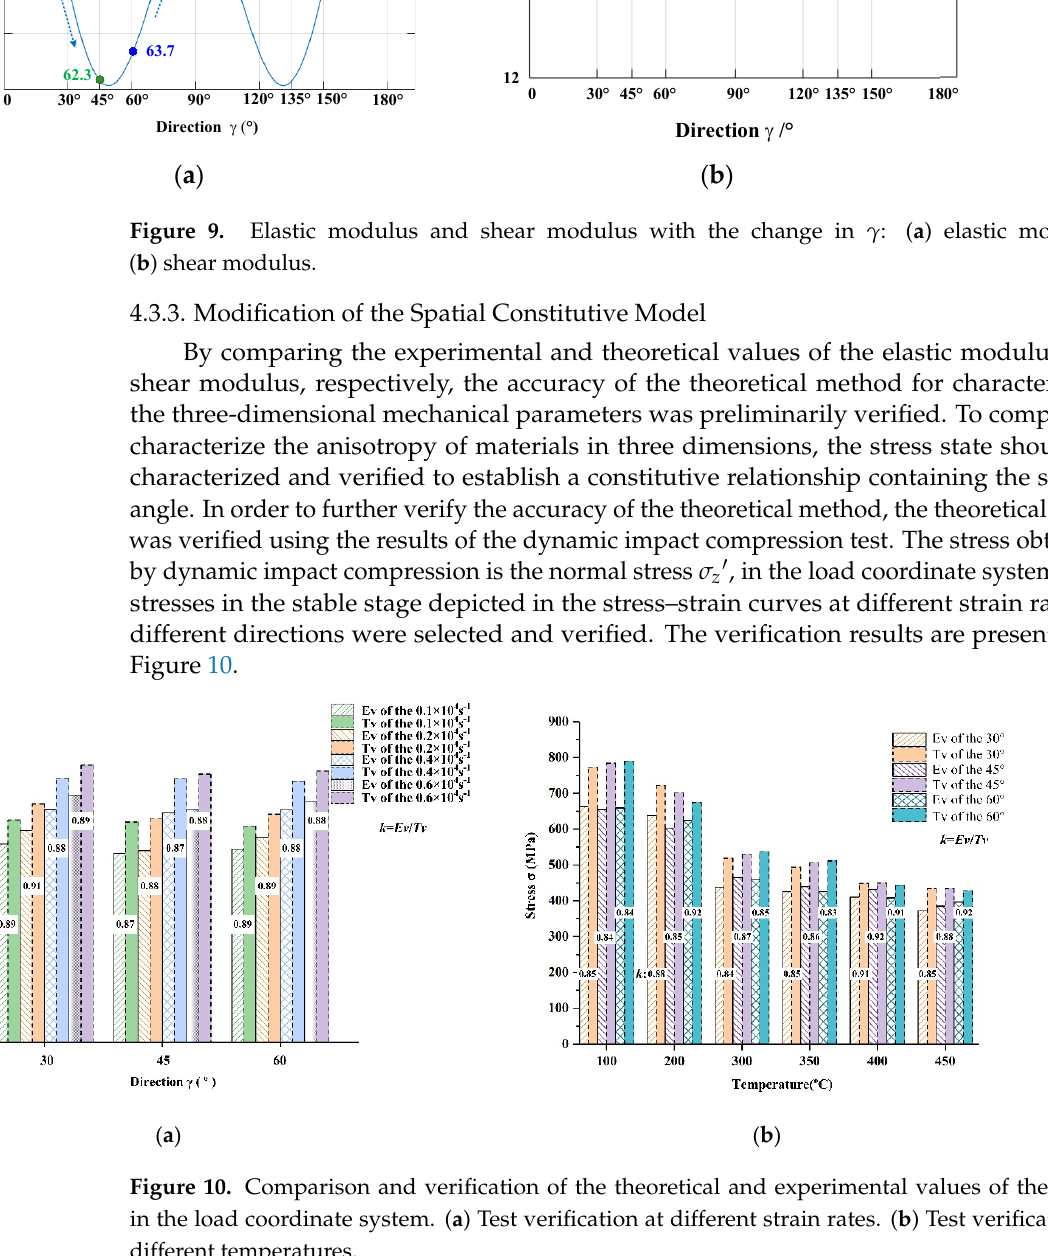
Figure 10. Comparison and verification of the theoretical and experimental values of the stress in the load coordinate system. ( a ) Test verification at different strain rates. ( b ) Test verification at different temperatures.